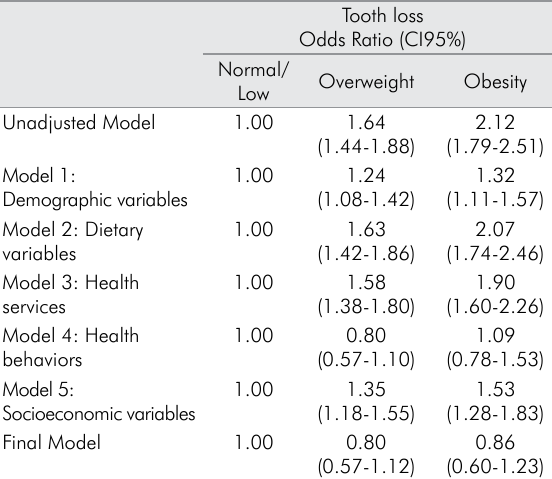
Table 2. Odds ratios of the regression models for outcomes: normal/low (BMI < 25kg/m²), overweight (BMI ≥ 25kg/m² and < 30kg/m²) and obese (BMI ≥